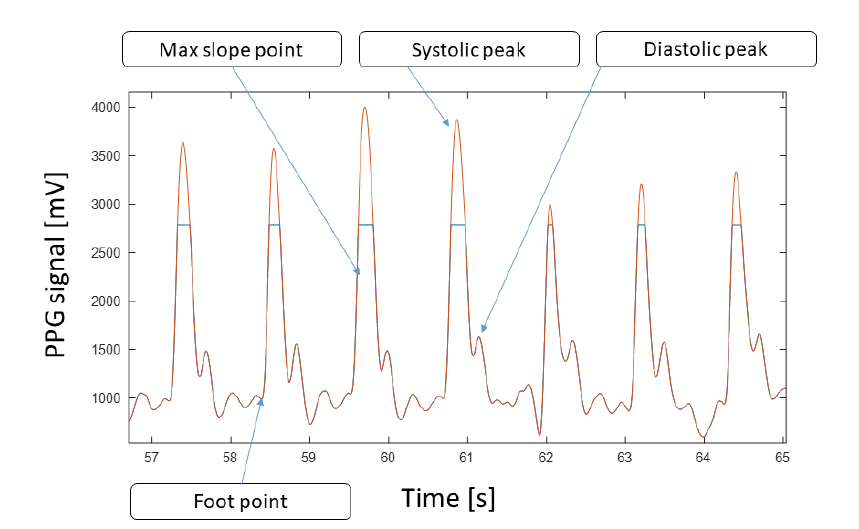
Figure 2. A seven beat PPG sequence showing clipping of the systolic peaks (blue curve) and the spline-based interpolation used (orange curve). The two fiducial points assessed is also marked in the